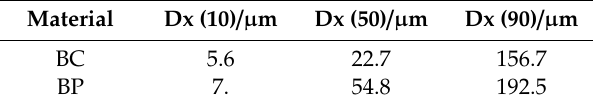
Table 3. Particle size distribution of BC and